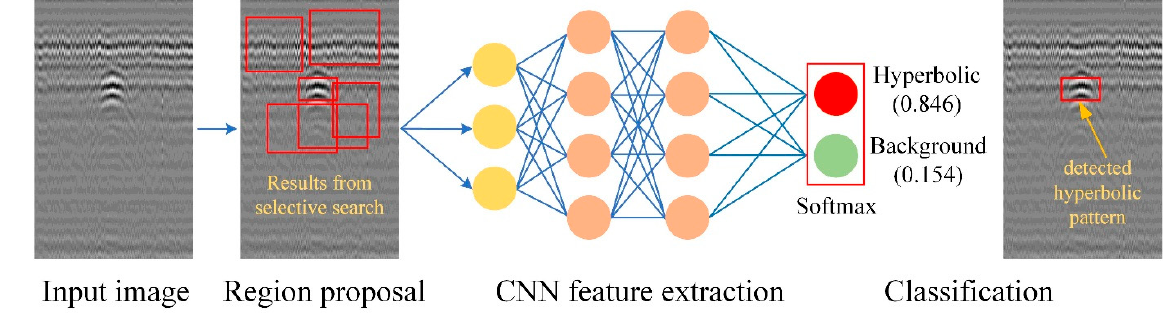
Figure 2. R-CNN object detection systems overview.